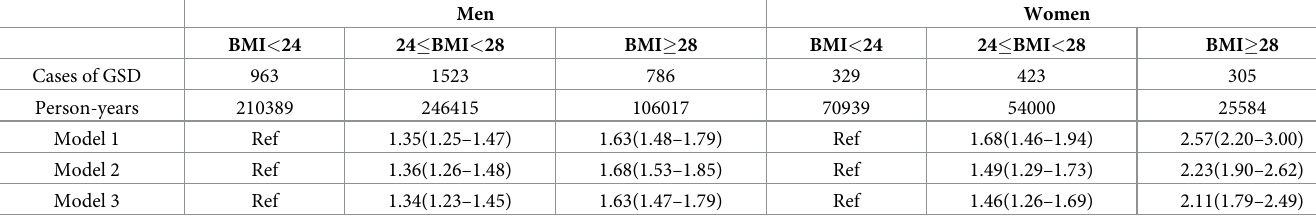
Table 2. Hazard ratios (HRs) and 95% confidence interval(CI) for risk of new-onset gallstone disease according to BMI subgroups.